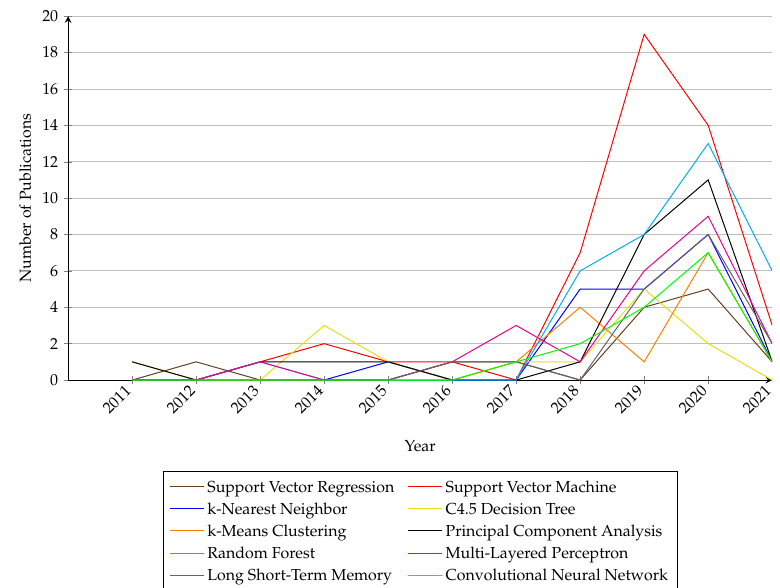
Figure 10. Algorithms used over